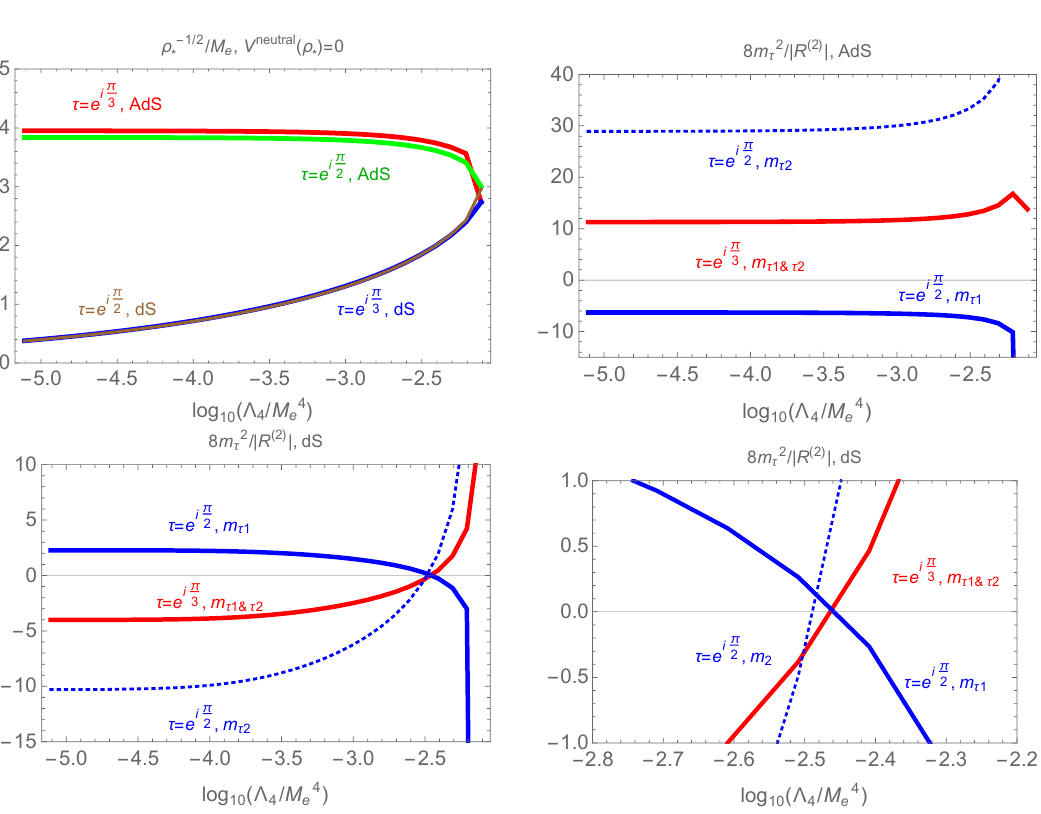
Figure 12 . U(1) gauge theory with neutral matter. In the upper left (cid:12)gure, the value of (cid:26) (cid:3) which satis(cid:12)es V ( (cid:26) (cid:3) ) = 0 is plotted. The ratio between the mass of the (cid:28) moduli and the curvature of 2-dimensional spacetime is depicted in the other plots. The vacuum is perturbatively unstable if this is negative ( dS 2 ; M 2 ) or smaller than (cid:0) 1 (AdS 2